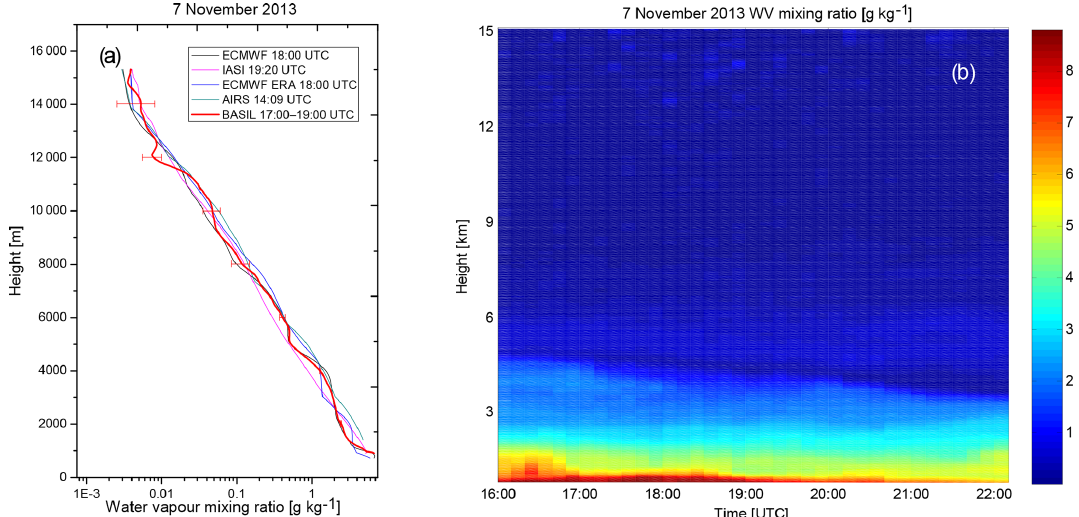
Figure 3. Water vapour mixing ratio profile as measured by BASIL over the time period from 17:00 to 19:00UTC on 7 November 2013, as well as the closest profiles (in time) from IASI (at 19:29 UTC), AIRS (at 14:09 UTC) and the ECMWF (ERA-15 and ERA-40, at 18:00UTC) model reanalysis (a) . Time evolution of the water vapour mixing ratio profile as measured by BASIL over the interval from 16:00 to 22:00UTC on 7 November 2013 (b)